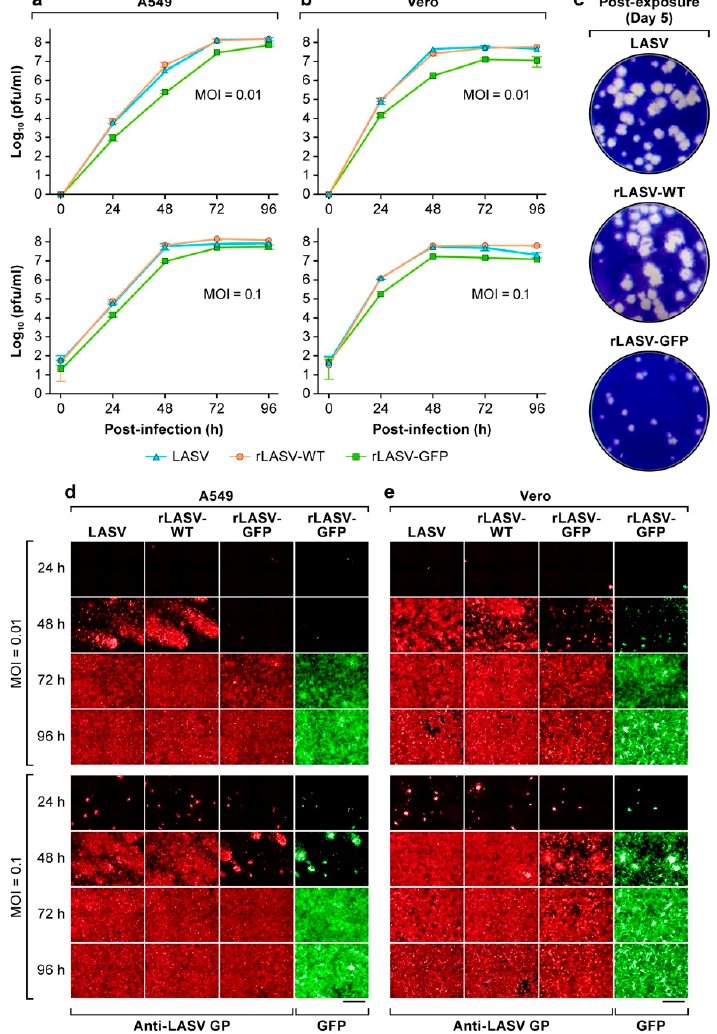
Figure 2. Growth kinetics of wild-type LASV, rLASV-WT, and rLASV-GFP in cultured cells. ( a ) Interferon (IFN)-competent (A549) and ( b ) IFN-deficient (Vero) cells were exposed to all with each virus at MOIs of 0.01 and 0.1. At the indicated time points post-infection (PI), TCS were collected, and virus titers were determined by plaque assay. Graphs represent the means ± standard deviations of triplicate samples. ( c ) Plaque morphologies of each virus on Vero cell monolayers. ( d , e ) At the indicated time points PI, A549 and Vero cells were fixed. LASV glycoprotein (GP) was detected (red) by immunofluorescence assay (IFA) using the 37.2G human monoclonal antibody to LASV GP [ 40 ] and compared to GFP expression (green). Fluorescence was assessed by high-content imaging. Bar, 200 µm.